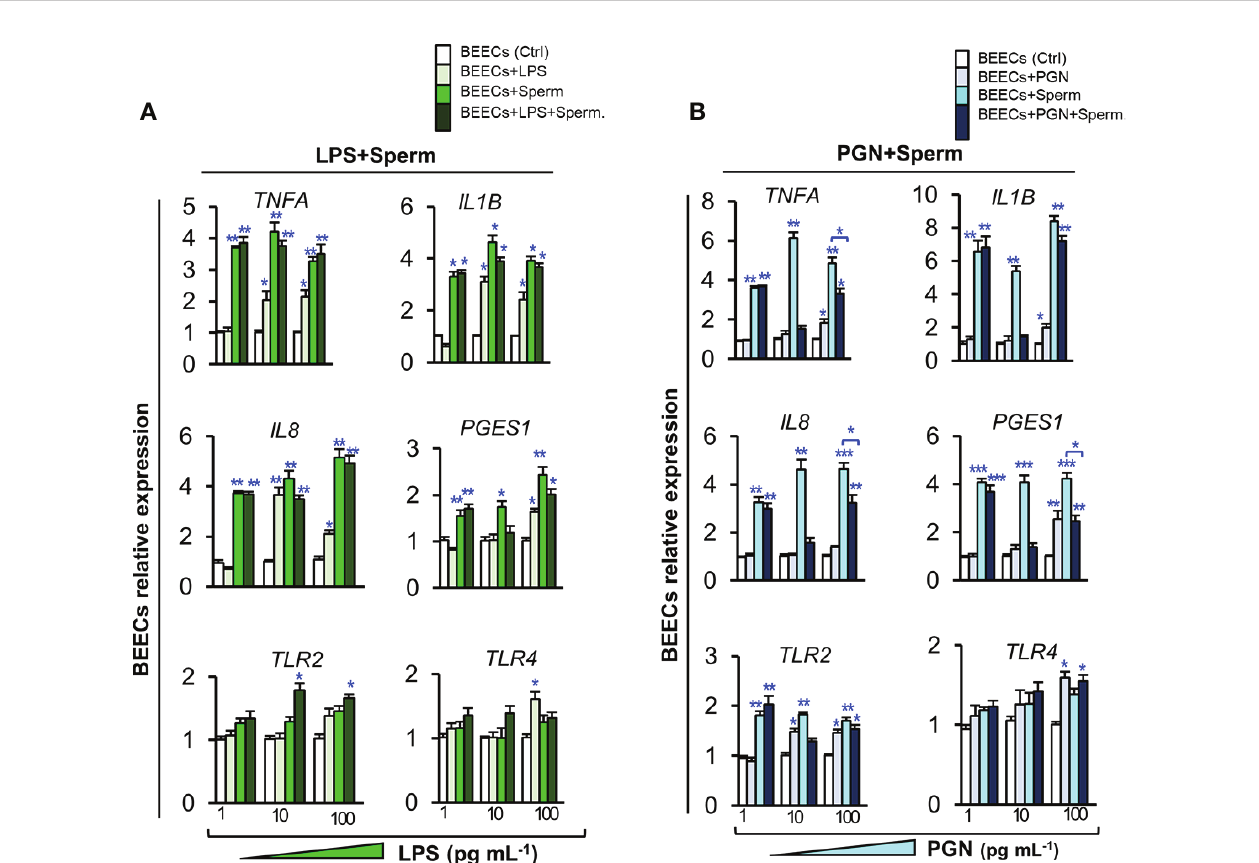
FIGURE 2 | Low levels of PGN, but not LPS, suppressed the stimulatory effect of sperm on the transcription of major in fl ammatory cytokines, chemokine, PGES1 and TLR2 in BEECs. Subcon fl uent BEEC monolayers were exposed to (A) LPS (1, 10, and 100 pg ml − 1 ), or (B) PGN (1, 10, and 100 pg ml − 1 ) for 24 h followed by co-culturing with sperm (5 × 10 6 cell ml − 1 ) for 6 h. The mRNA transcription levels of major in fl ammatory genes ( TNFA, IL1B, IL8, PGES1, TLR2 , and TLR4 ) were quanti fi ed by real-time PCR assay. The animal was designated as the statistical unit, and the data was obtained from 3 replicated independent experiments, using BEECs from 3 different uteri, (3 wells/treatment/experiment) presented as mean ± SEM. Asterisks denote a signi fi cant variance (*P < 0.05 **P < 0.01 , or ***P < 0.001) between the different treatment groups when compared to the control group at each PGN/LPS concentration. Asterisk denotes a signi fi cant variance (*P < 0.05) between the ‘ Sperm ’ and ‘ PGN+Sperm ’